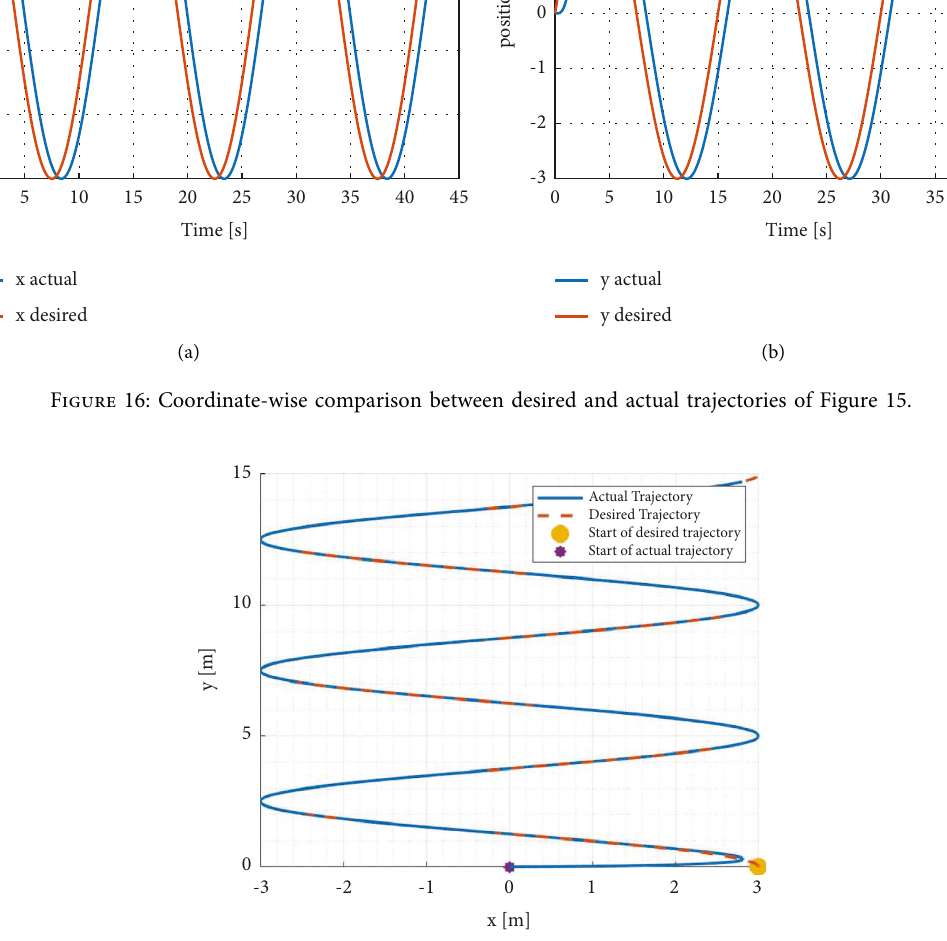
Figure 17: Desired and actual trajectories with feedback linearization and PD controller.